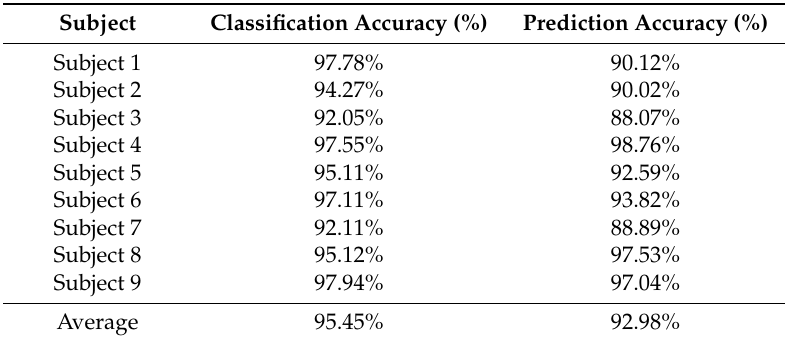
Table 3. Classification and prediction accuracy for individual